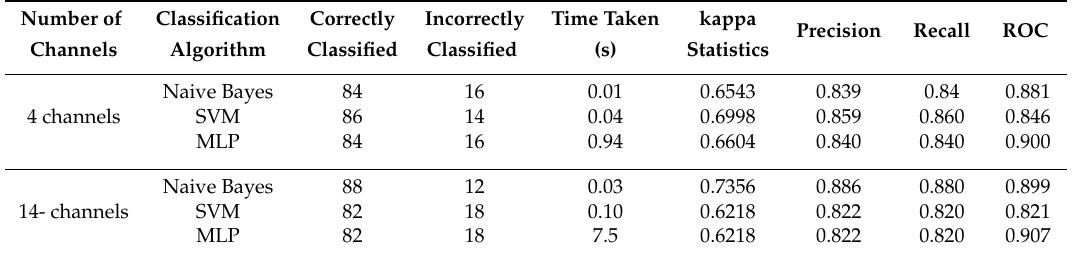
Table 2. Performance parameters of classification algorithms using the four selected channels and all fourteen available